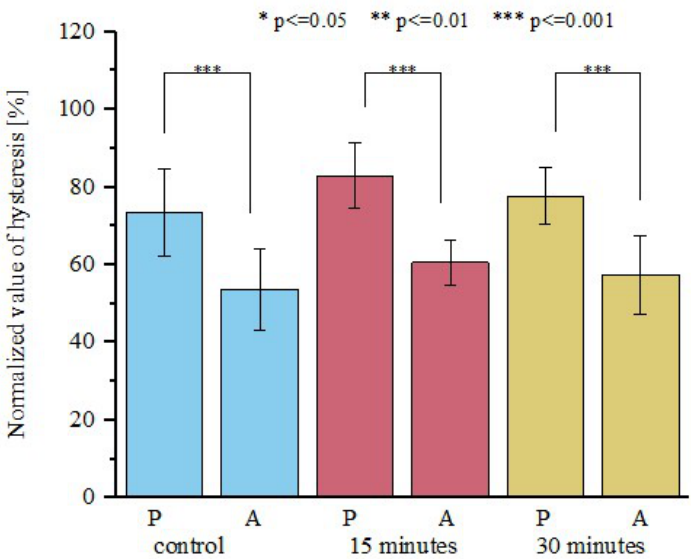
Figure 5. Normalized values of hysteresis for posterior and anterior tendon fascicle bundles. Values are shown for control samples, as well as for samples which were open-air dried for 15 and 30 min. Drying does not influence energy dissipation of the material; n = 10.